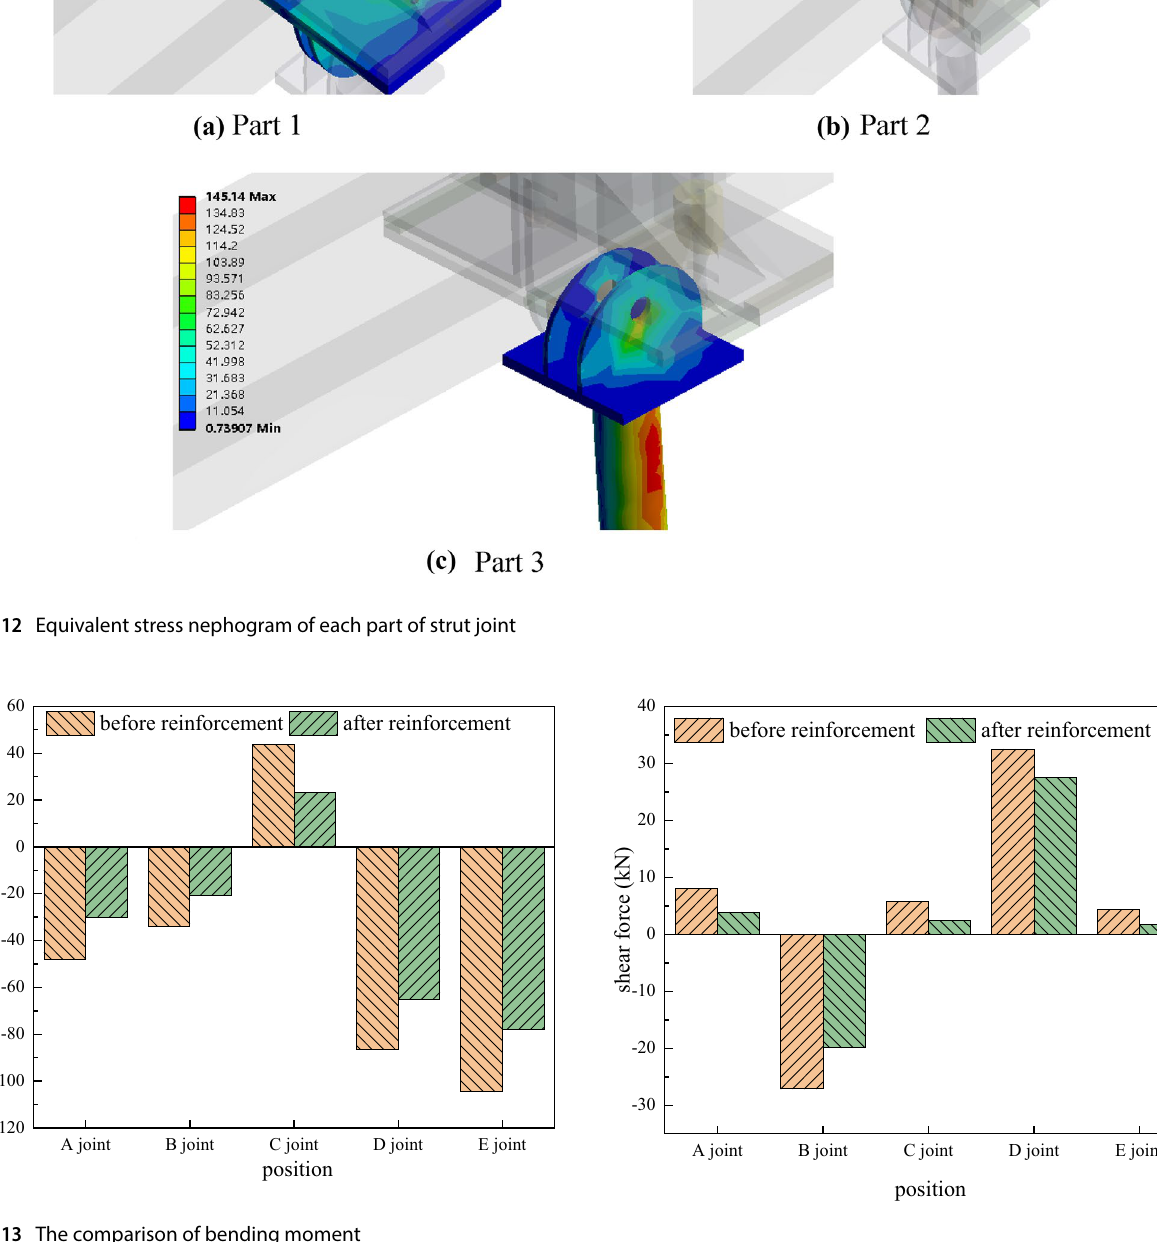
Fig. 14 The comparison of shear